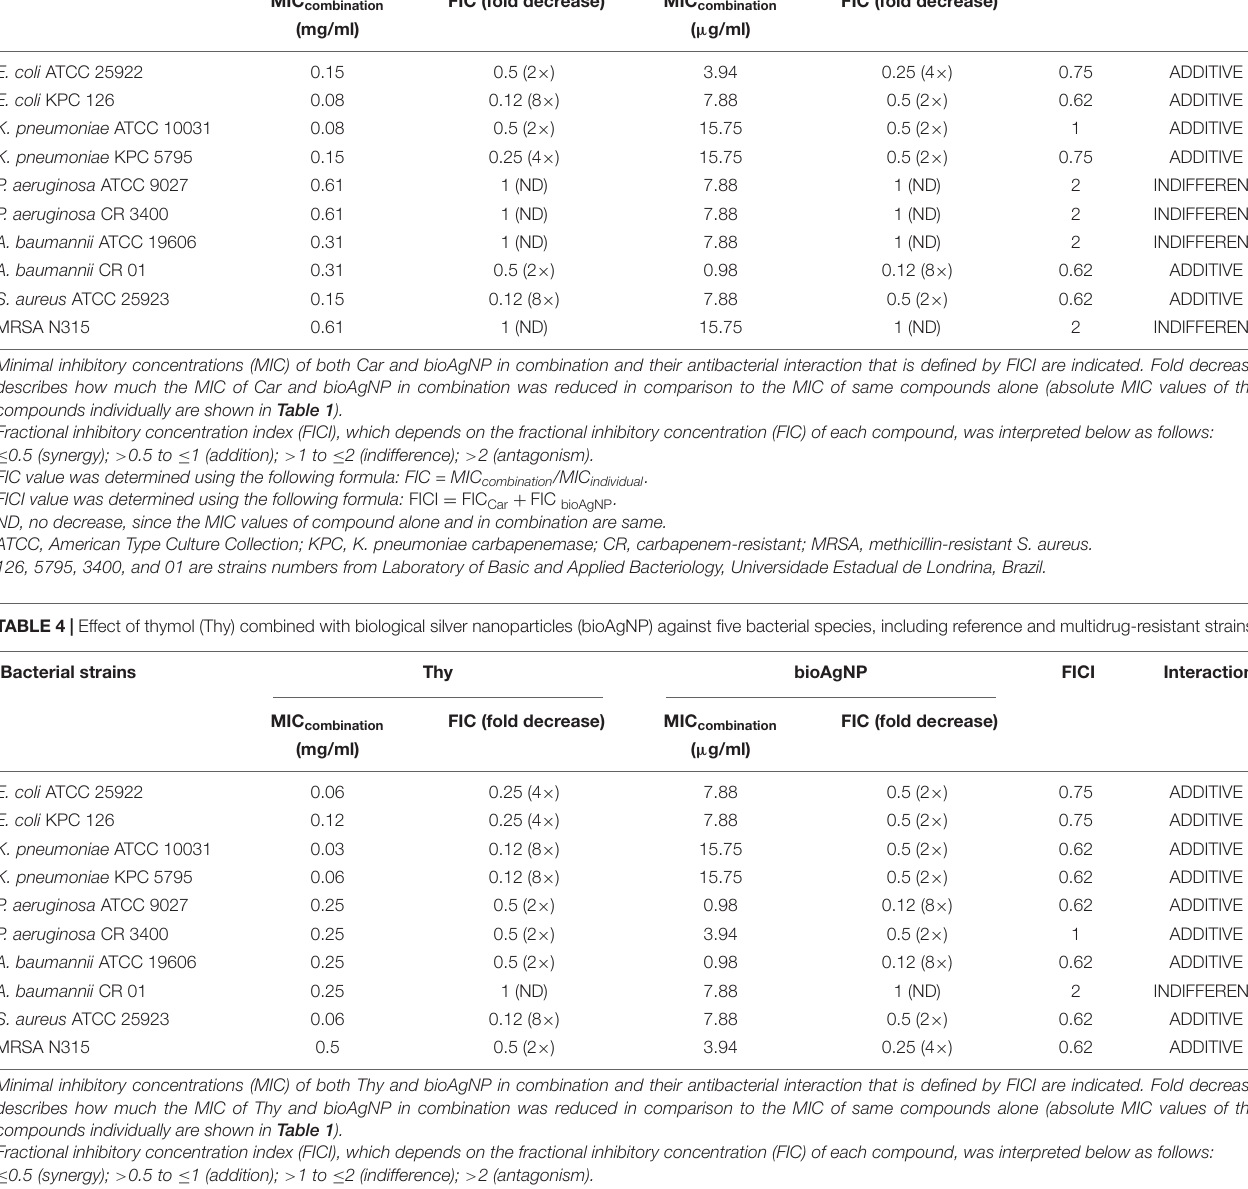
TABLE 3 | Effect of carvacrol (Car) combined with biological silver nanoparticles (bioAgNP) against five bacterial species, including reference and multidrug-resistant strains. Bacterial strains Car bioAgNP FICI Interaction